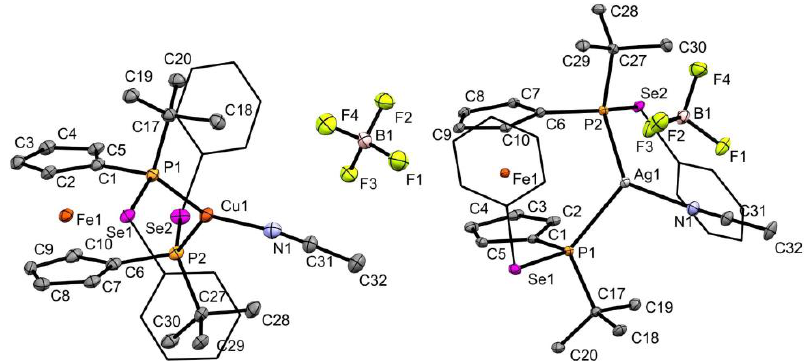
Figure 5. Molecular structure of 5 and 6 in solid state. Ellipsoids are shown at 30% probability, and all hydrogen atoms have been omitted for clarity. The phenyl substituents at Se1 and Se2 are indicated as wireframe for better overview. For 5 and 6 , two molecules were found within the unit cell from which one is depicted. Selected bond lengths and angles of 5 : Se1-P1 2.2556(14) Å , Se2-P2 2.2408(14) Å , Cu1-P1 2.2465(14) Å , Cu1-P2 2.2611(14) Å , Cu1-N1 1.944(5) Å, tilt angle α =2.3(2)°, torsion angle τ = 47.97° and 6 : Se1-P1 2.2523(7) Å , Se2-P2 2.2542(7) Å , Ag1-P1 2.4758(7) Å , Ag1-P2 2.4438(7) Å , Ag1-N1 2.233(3) Å, tilt angle α = 2.25(14)°, torsion angle τ = 54.97°.